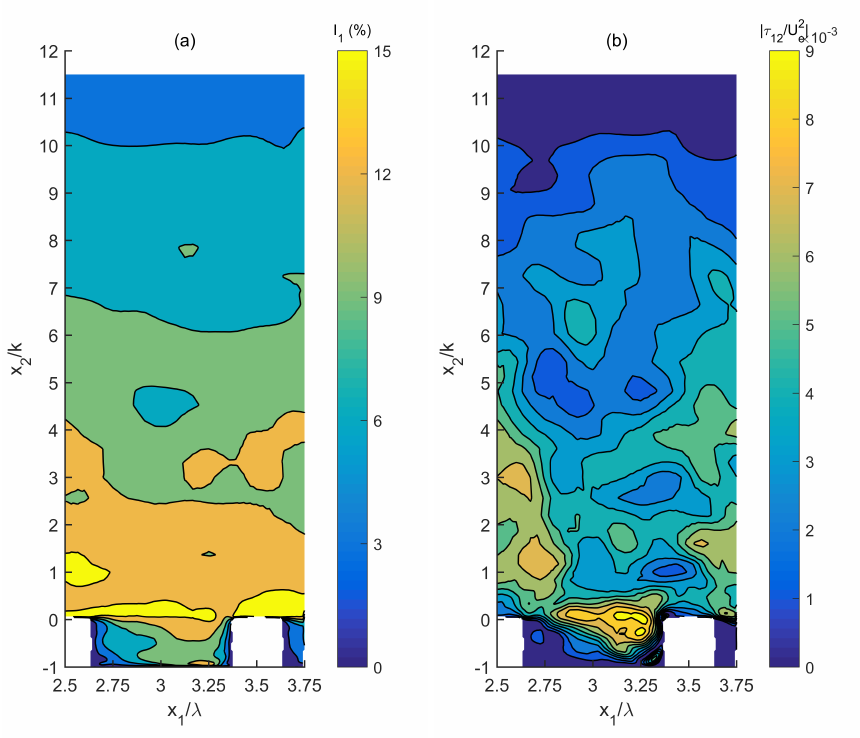
Figure 16. Vertical planes (at x 3 = 0.0375 m) showing predicted distributions of: ( a ) relative turbulence intensity component I 1 ; ( b ) specific Reynold shear stress − u (cid:48) squared U 2 e . The distributions are from LES outputs for Run 2.